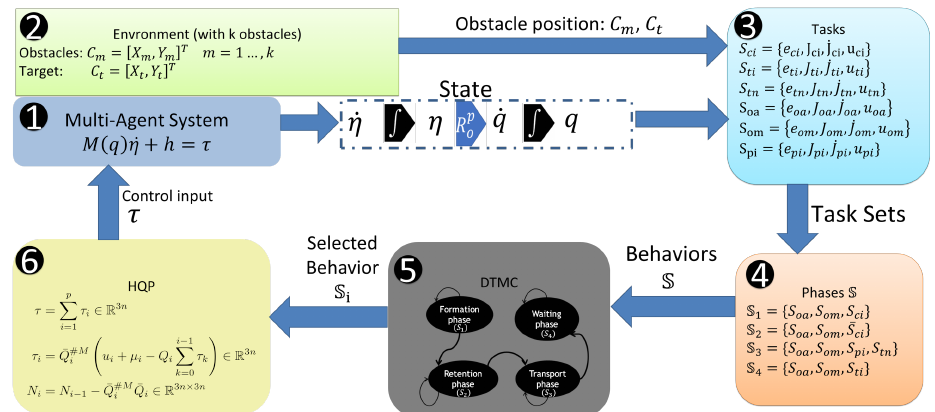
Figure 9. Process blocks of the Manipulation scheme. 1. Robots, given by (6); 2. Environment; 3. Tasks, given from (7) to (25); 4. Phases, presented in Table 2; 5. DTMC, whose probability is given by (36); and finally 6. HQP, given by (30).